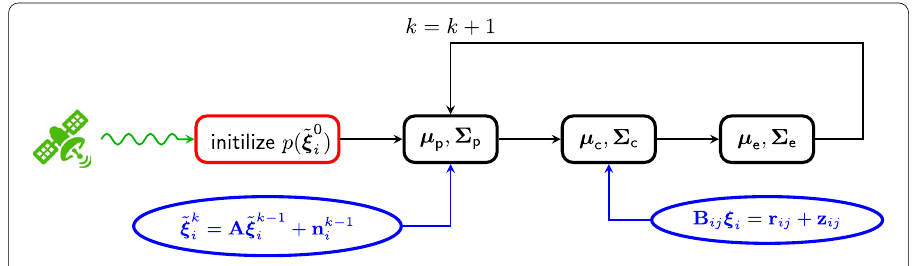
Fig. 8 A summary of the BRF-based pairwise synchronization and joint sync&loc. The satellite information is used to initialize the joint sync&loc algorithm described in Sect.